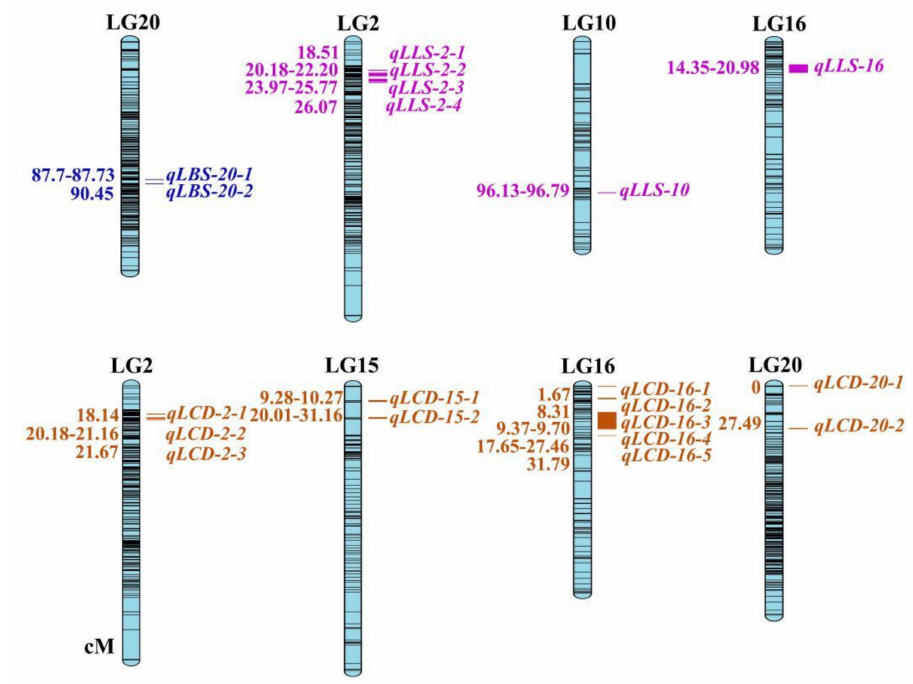
Figure 5. The quantitative trait loci (QTLs) test for the LBS (leaf blade shape), LLS (leaf lobe shape) and LCD (leaf crack depth). The left of each linkage group is the location of the QTL, and the unit is cM. The right side is the QTL name. The QTL naming method is shown as follows: "q" + "target trait (uppercase English letter)" + " − " + "chromosome number or linkage group code" + "QTL number". The full name of QTL is usually expressed in italics.